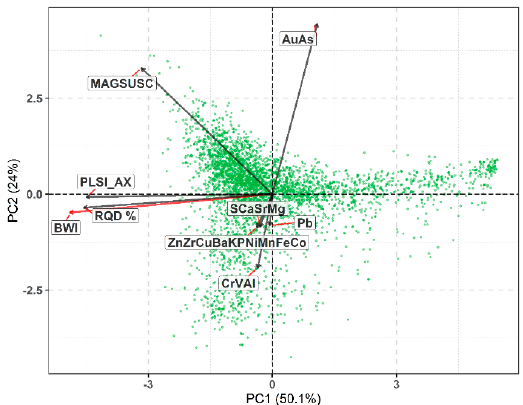
Figure 9. Principal component 1 (PC1) and PC2 biplot of compositional and non-compositional variables for weathered and fresh rock observations. Green data points represent PC scores and the arrow vectors represent the orebody variables. The BWI loading is shown in red for clarity.